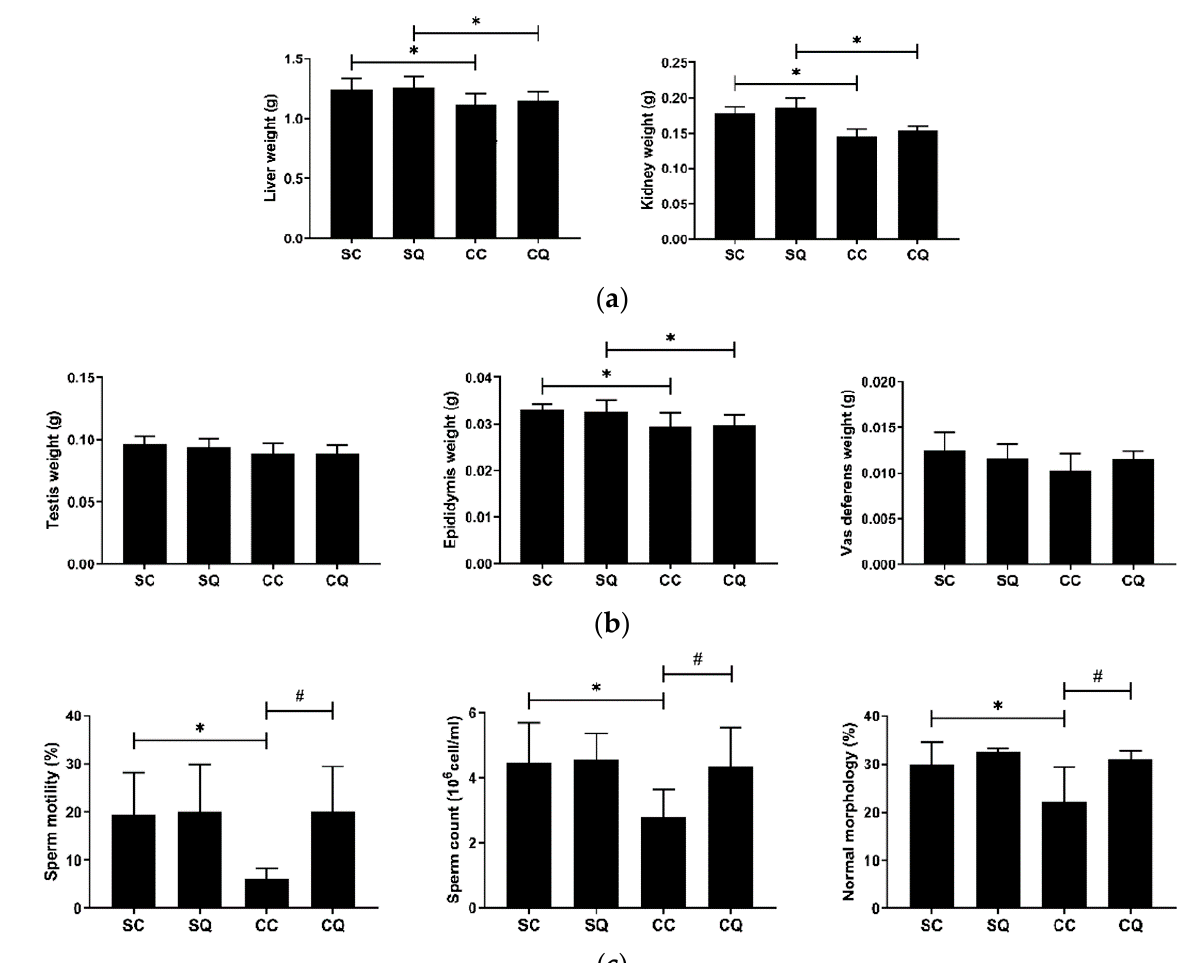
Figure 3. ( a ) Liver and kidney weights; ( b ) testis, epididymis and vas deferens weights; and ( c ) parameters of semen quality in the sham surgery and CKD surgery mice treated with vehicle (corn oil) or CoQ10. SC: sham surgery mice with vehicle; SQ: sham surgery mice with CoQ10; CC: CKD surgery mice with vehicle; CQ: CKD surgery mice with CoQ10. Data are expressed as the mean ± SD ( n = 9 per group). * p < 0.05 denotes a significant difference between the sham surgery and CKD surgery groups (SC vs. CC and SQ vs. CQ); # p < 0.05 denotes a significant difference between the vehicle treatment and CoQ10 treatment groups (SC vs. SQ and CC vs. CQ). CoQ10, coenzyme